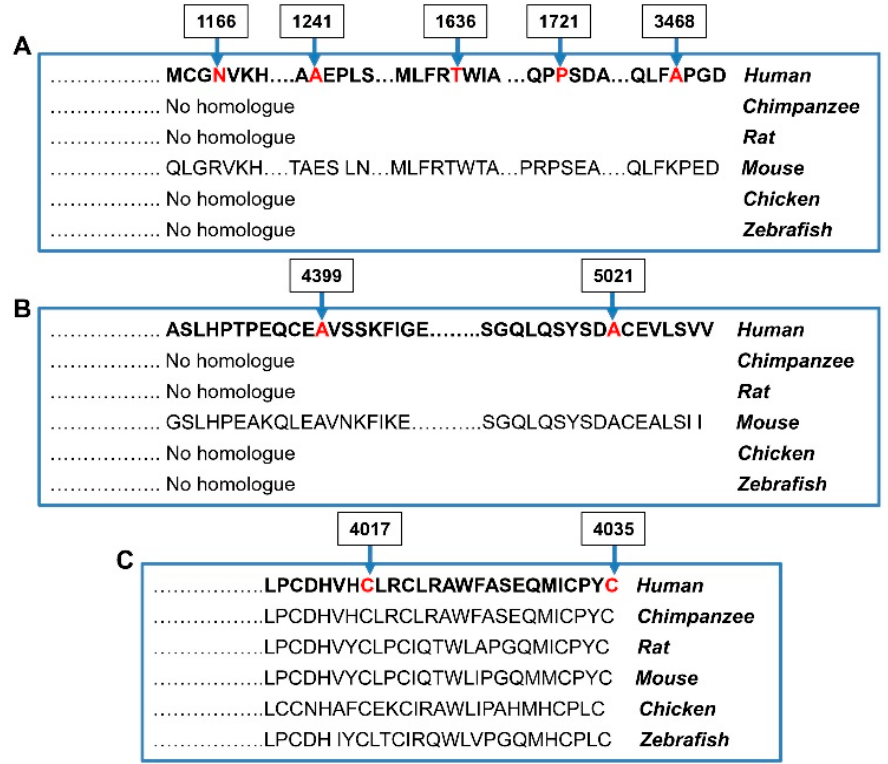
Figure 4. Conservation degree of RNF213 missense variants in ( A ) N-terminal domain, ( B ) C-terminal domain and ( C ) RING finger domain, across 6 species. There is an observably high conservation of Cysteine 4017 and 4035 in the RING finger domain. The mutated amino acids identified in our study are shown in red colour.